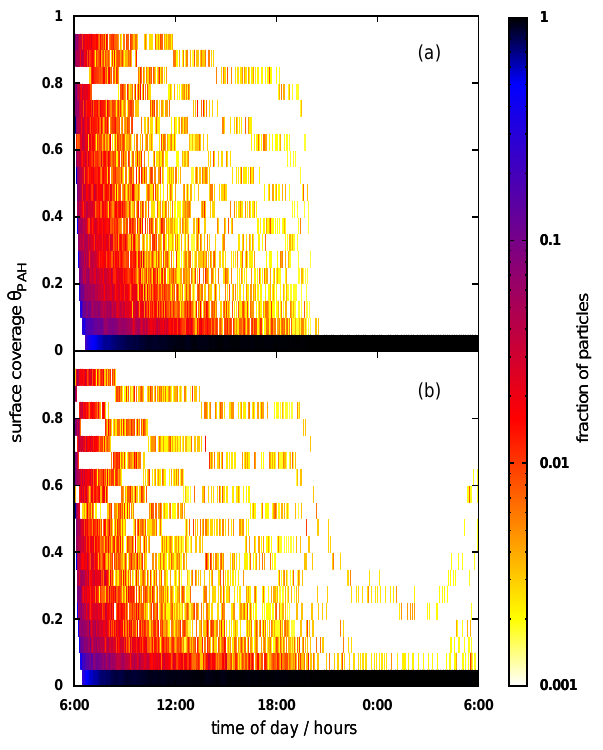
Fig. 6. Particle PAH surface coverage during the simulated 24h pe- Fig. 6. PAH particle surface coverage during the simulated 24 h period, averaged over the whole particle riod, averaged over the whole particle population. Panels (a) and population. Panels (a) and (b) represent scenarios A and D, respectively. Fractional PAH surface coverage is (b) represent scenarios A and D, respectively. Fractional PAH sur- face coverage is plotted on the vertical axis in bins of width 0.05 plotted on the vertical axis in bins of width 0.05 and color coding gives the fraction of particles in the population and color coding gives the fraction of particles in the population with the corresponding coverage. with the corresponding